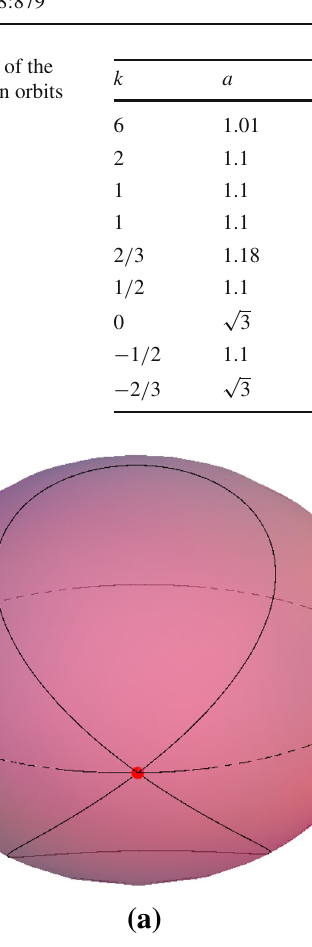
Fig. 10 Illustration of the special cases of the polar SPOs: oscillatory orbit with a = 1 . 17986 = a (cid:4)φ = 0 ( min ) at r = 1 . 7147 = r (cid:4)φ = 0 ( max ) a and the SPO with a = 1 . 17996 = a pol ( max ) at the coalescing radius